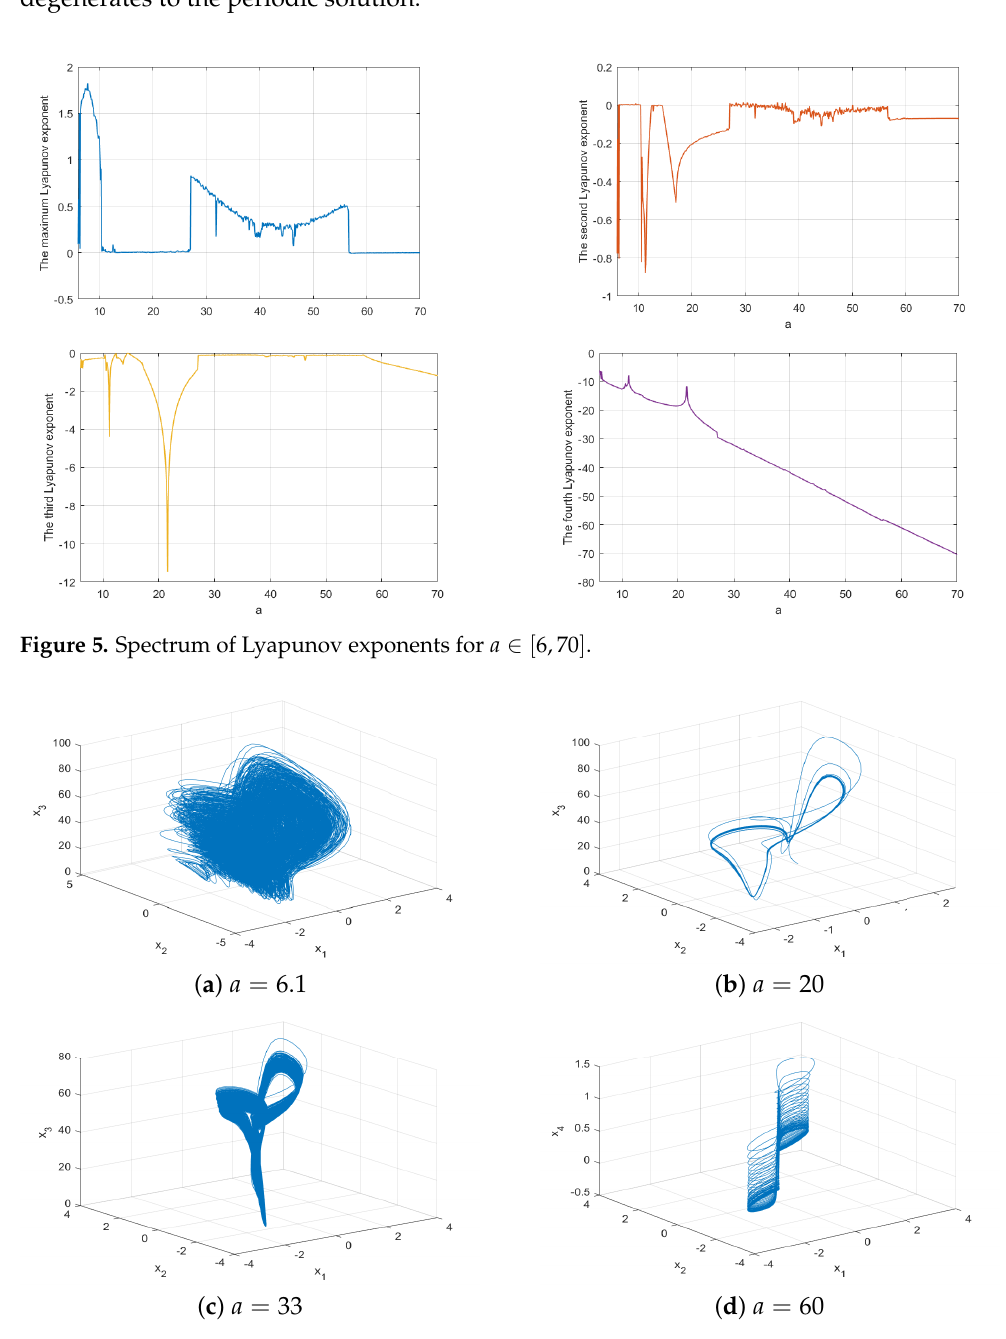
Figure 6. Phase portraits of system (1) for b = 28, c = 8/3, d = 0.1 and different a